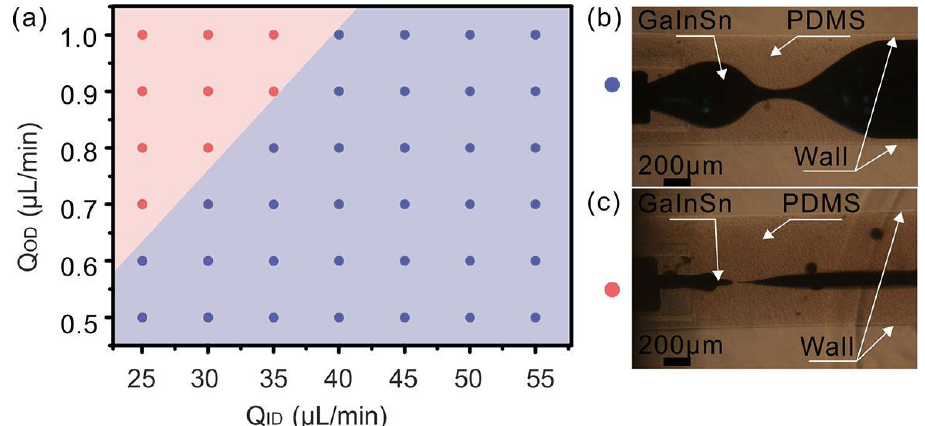
Figure 4. The flow behavior of liquid alloy in CNINC. ( a ) The distribution of instability states in CNINC; ( b ) if Q ID /Q OD ≥ 40 approximately, the GaInSn flow keeps continuous but not uniform and the flowrate of outer flow PDMS is relatively little so that it cannot wrap the inner flow GaInSn completely, which is marked with blue dot; ( c ) the GaInSn flow is pinched off by PDMS flow when Q ID /Q OD < 40, which is marked with red dot. Upper right: Q ID = 45 μL/min, Q OD = 1 μL/min. Lower right: Q ID = 30 μL/min, Q OD = 1